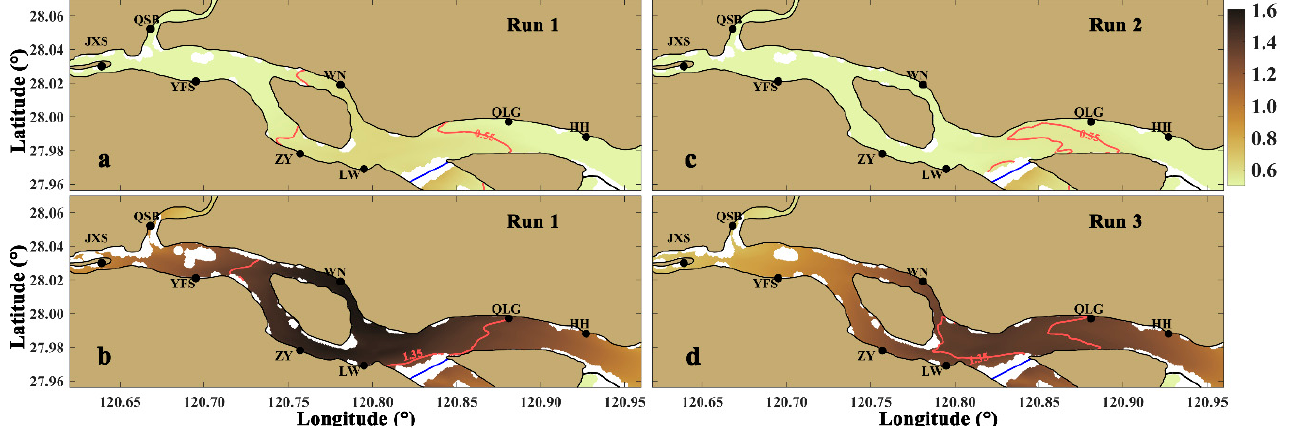
Figure 10. Distribution diagram of tidally averaged bottom SSC (filled contour, unit: kg·m − 3 ) under ( a , b ) the low-discharge condition and ( c , d ) PRD condition. Upper panels are during neap tide, and lower panels are during spring tide. White areas indicate tidal flat.